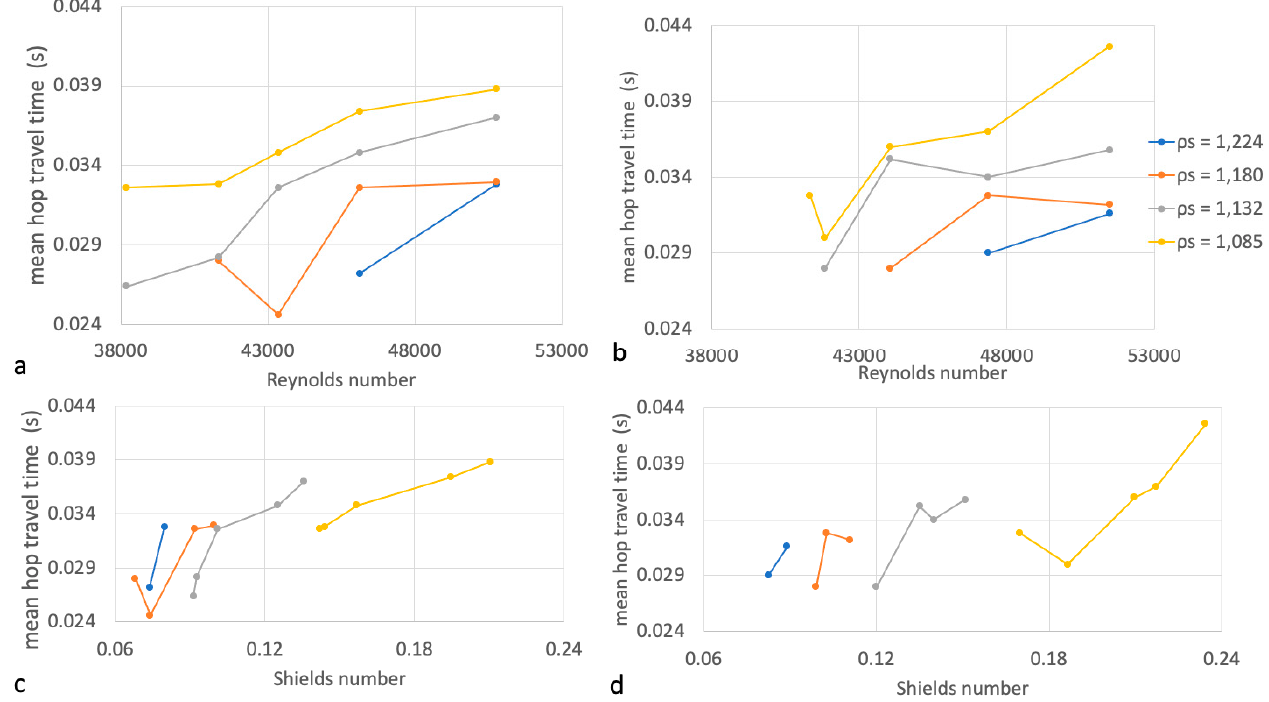
Figure 14. Mean hop travel time for different instrumented particle densities: ( a ) against Reynolds number, for bed surface A, ( b ) against Reynolds number, for bed surface B, ( c ) against Reynolds number, for bed surface A, and ( d ) against Reynolds number, for bed surface B.